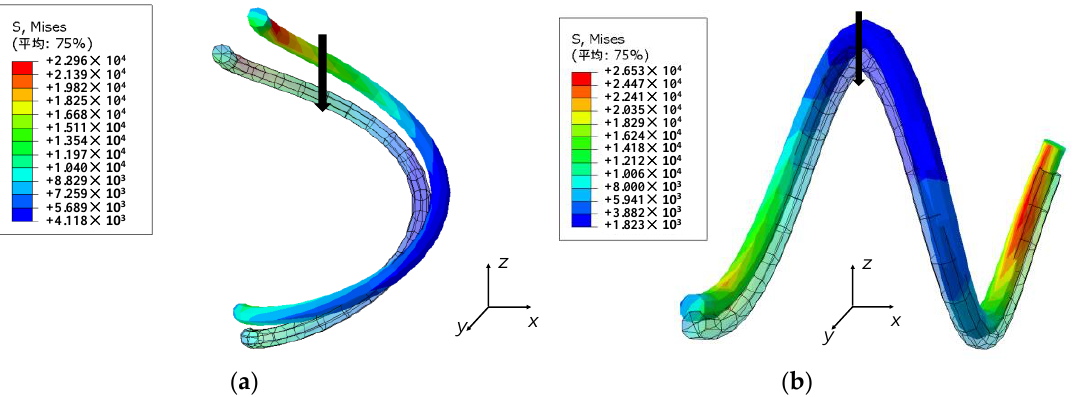
Figure 15. Expansion deformation of the wire helix in longitudinal and lateral arrangement: ( a ) Longitudinal; ( b ) Lateral.